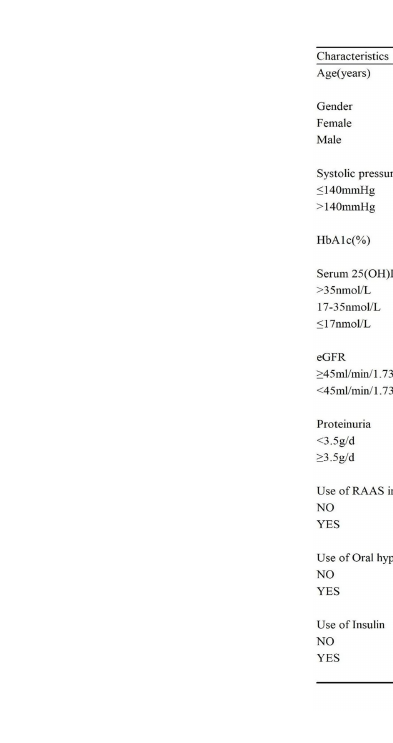
Frontiers in Endocrinology |